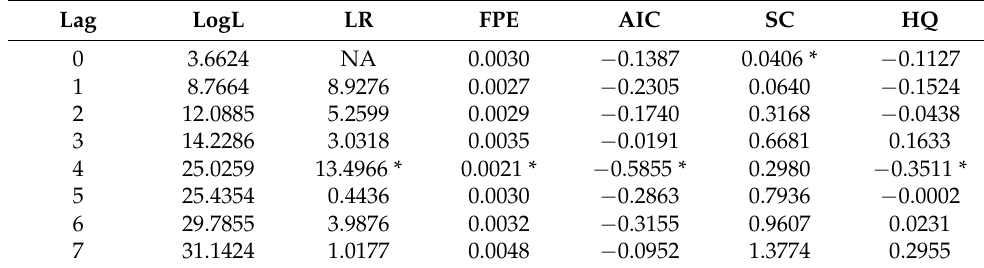
Table 3. Selection criteria for optimal lag order of VAR